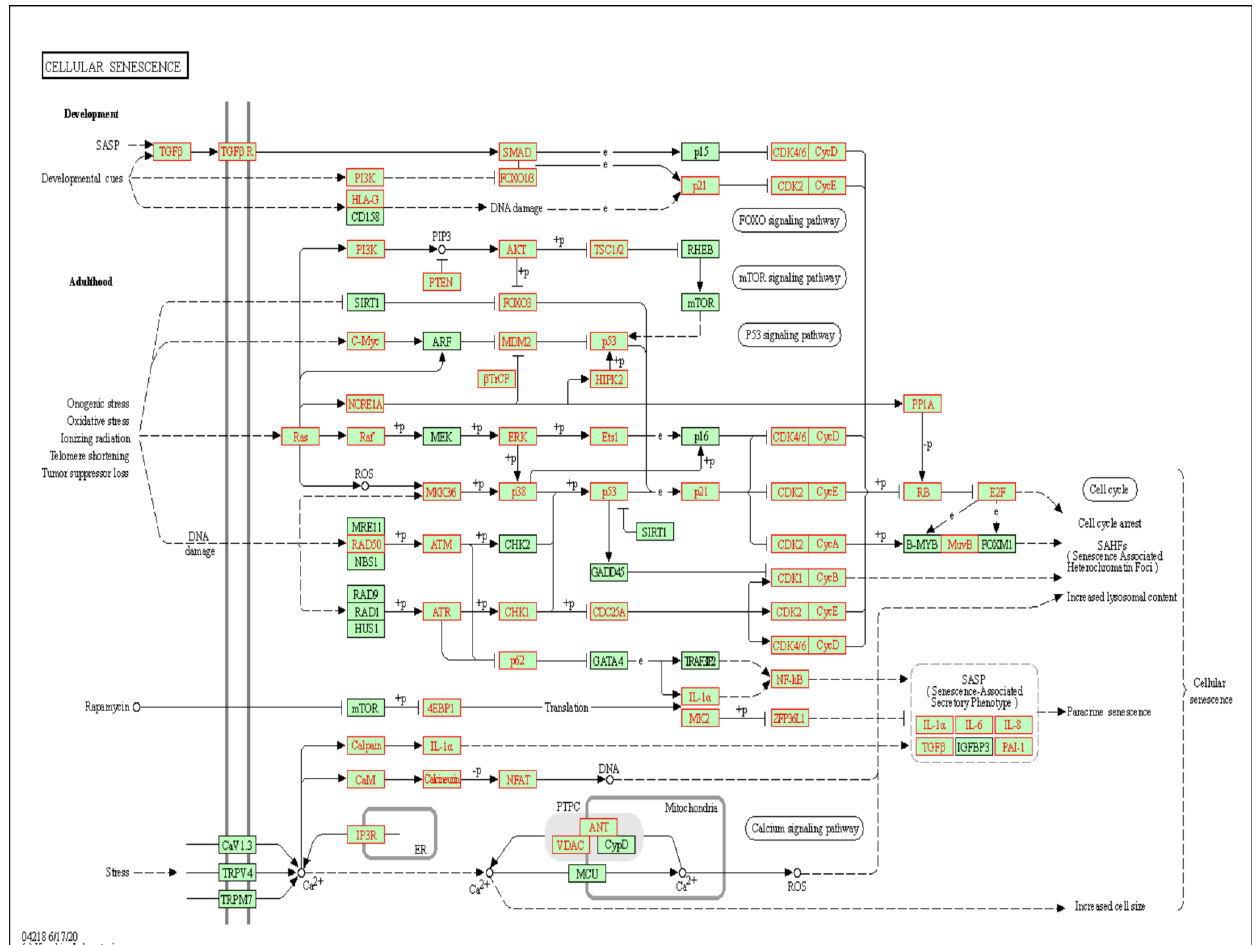
Figure 4. Gene pathway representation of interactions between gene target predictions of the 22 differentially expressed microRNAs. The most significant KEGG pathway of cellular senescence is identified by over-representation analysis with the gene list derived from the validated target genes of the 22 miRNAs (see Section 2). The FDR-adjusted p -value of the pathway is 1.2 × 10 − 13 . Predicted target genes are shown in red letters and boxes with red lines.